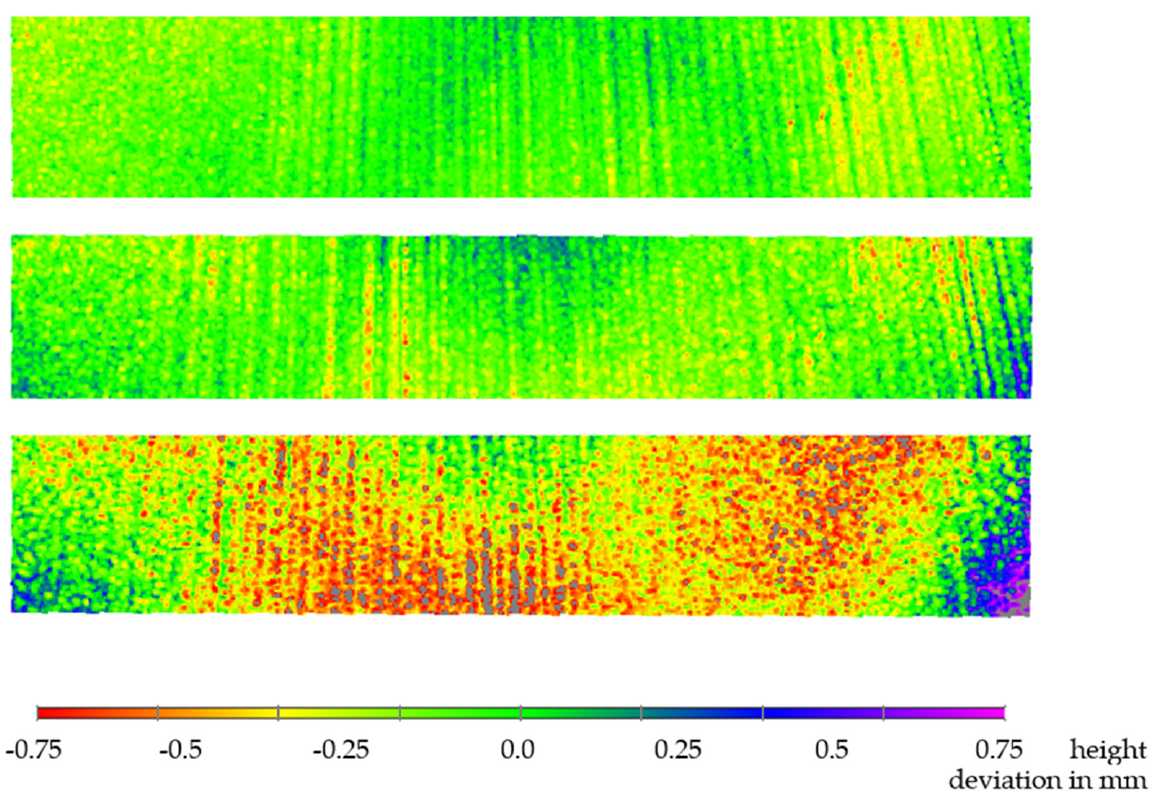
Figure 5. False-color representation of flatness deviation: measurement distance of 1.7 m ( above ), 2.0 m ( middle ), and 2.4 m ( below ).